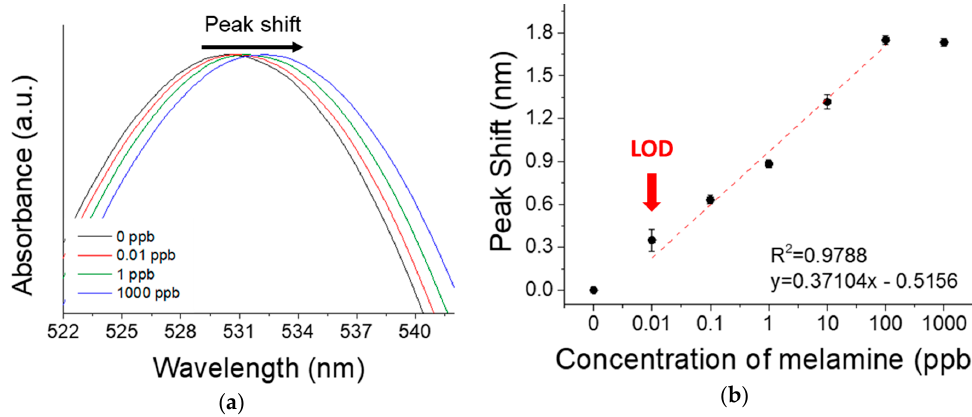
Figure 2. Melamine detection by p -NA-based cuvette-type LSPR sensor. Peak (wavelength) shift for different melamine concentrations (0–1000 ppb). ( a ) The change of the plasmon spectrum and ( b ) the linear correlation with the melamine concentration in standard solution. All experiments were performed with five measurements, and the data represent mean ± standard deviation. The coefficient of variation (% CV) is below 10%.